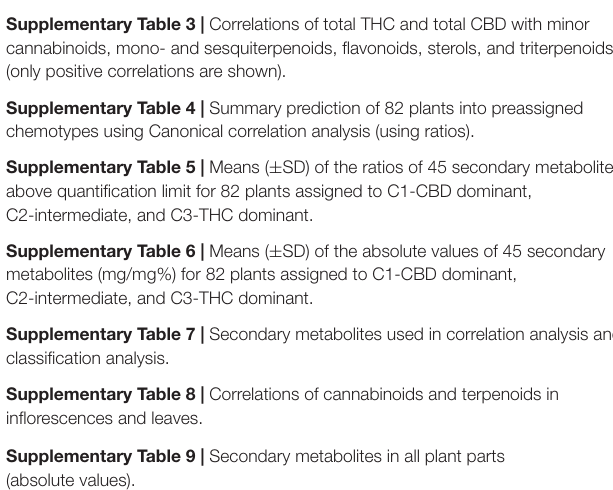
Supplementary Table 2.3 | Cannabinoid profile in leaves of 82 plants for three chemotypes. Supplementary Table 2.4 | Cannabinoid profile in stem bark of 82 plants for three chemotypes. Supplementary Table 2.5 | Mono- and sesquiterpenoids profile in inflorescences of 82 plants for three chemotypes. Supplementary Table 2.6 | Mono- and sesquiterpenoids profile in leaves of 82 plants for three chemotypes. Supplementary Table 2.7 | Flavonoids profile in inflorescences for three chemotypes. Supplementary Table 2.8 | Flavonoids profile in leaves for three chemotypes. Supplementary Table 2.9 | Sterols profile in stem bark for three chemotypes. Supplementary Table 2.10 | Sterols profile in roots for three chemotypes. Supplementary Table 2.11 | Triterpenoids profile in stem bark for three chemotypes. Supplementary Table 2.12 | Triterpenoids profile in roots for three chemotypes. Supplementary Table 3 | Correlations of total THC and total CBD with minor cannabinoids, mono- and sesquiterpenoids, flavonoids, sterols, and triterpenoids (only positive correlations are shown).